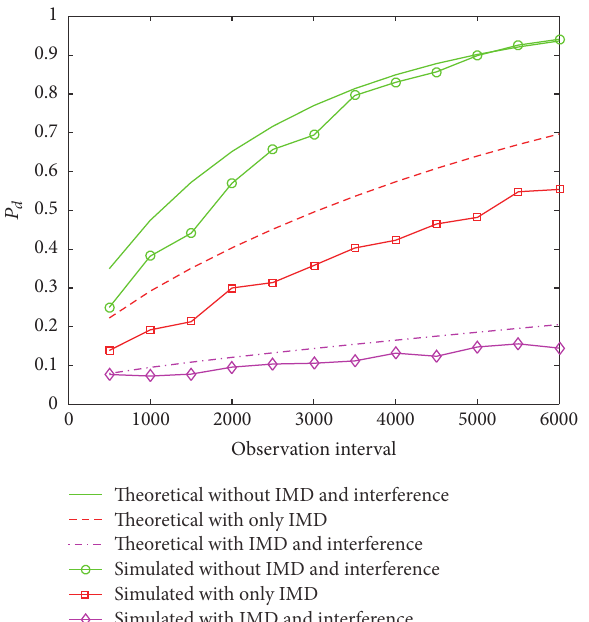
Figure 9: Effect of sensing time on the performance of ED at 𝑃 fa = 0.05 .